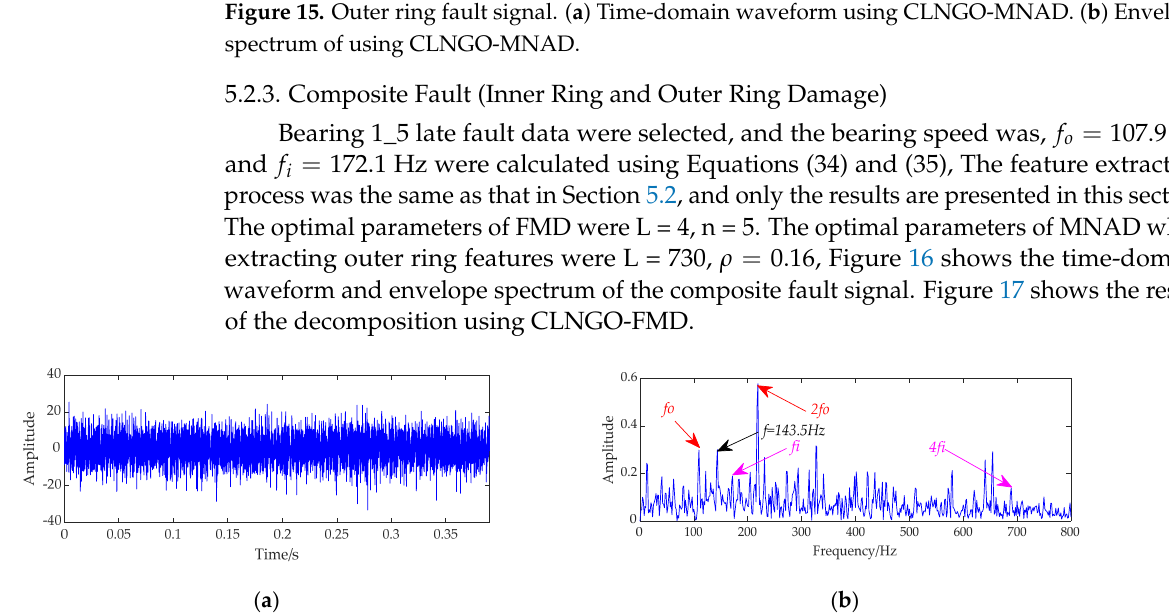
Figure 16. Composite fault signal. ( a ) Time-domain waveform. ( b ) Envelope spectrum.